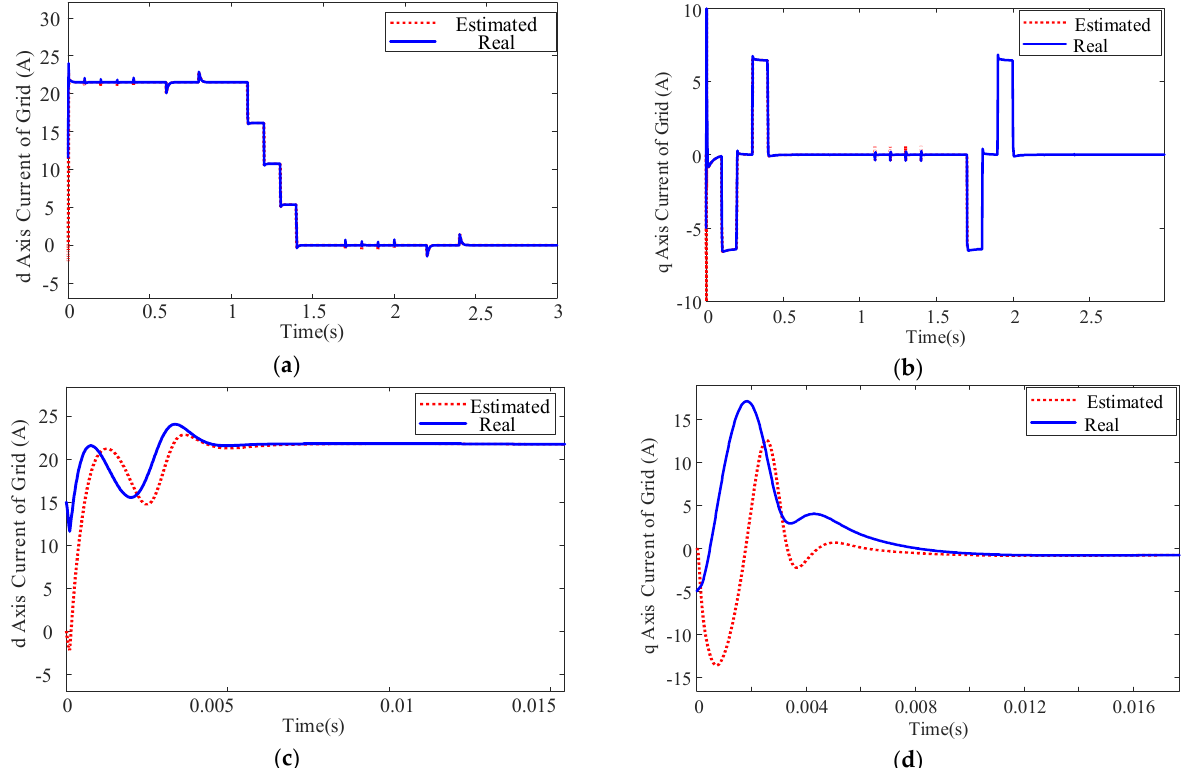
Figure 7. D and q Axis value of grid currents (real and estimated value): ( a ) d axis current; ( b ) q axis current; ( c ) zoomed view of d axis current in startup; and ( d ) zoomed view of q axis current in